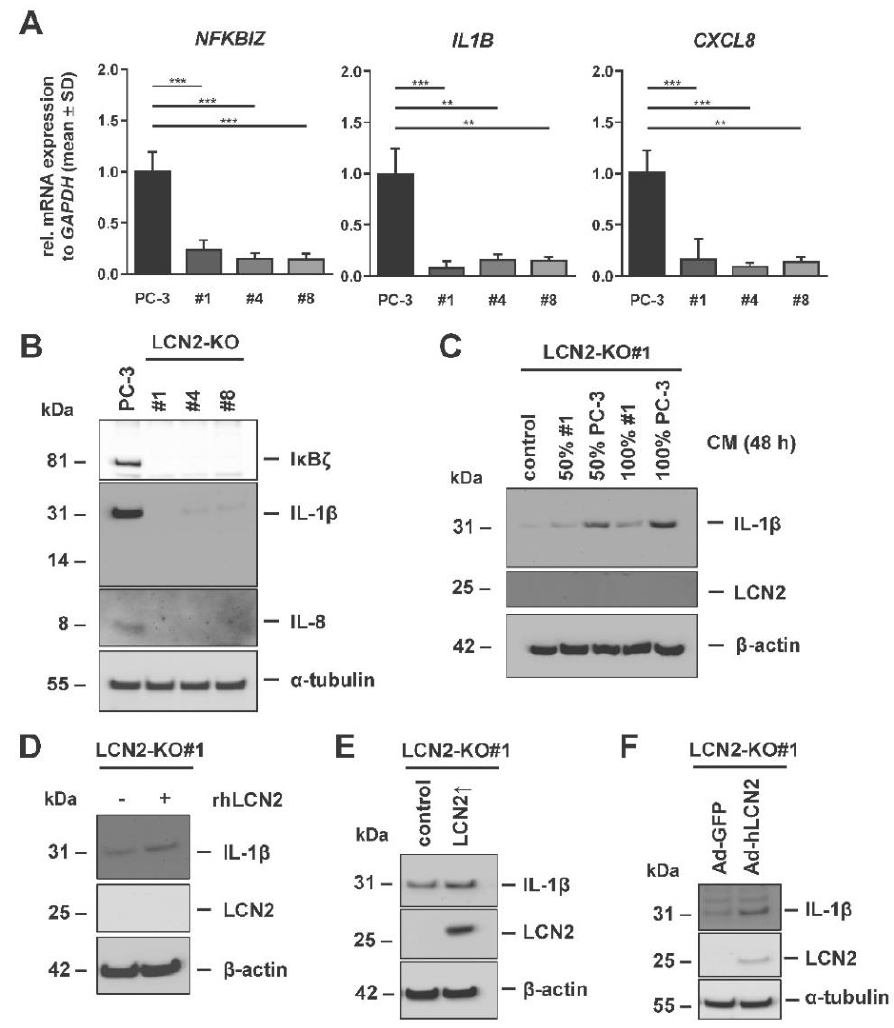
Figure 5. LCN2 depletion in PC-3 cells resulted in reduced expression of pro-inflammatory cytokines. ( A ) Quantitative mRNA expression analysis of NFKBIZ , IL1B and CXCL8 was performed in PC-3 and LCN2-KO (#1, #4, #8) cells grown in basal conditions (n = 3). The mRNA expression of these genes was significantly reduced in all analyzed LCN2-KO cells test. mRNA expression was normalized to GAPDH and are given in relation to parenteral PC-3 cells. Differences between the groups reaching significance are indicated as ** p < 0.01, *** p < 0.001. ( B ) Western Blot analysis confirmed reduction in I κ B ζ , IL-1 β and IL-8 protein expression in LCN2-KO cells compared to parental PC-3 cells (n = 3). ( C ) LCN2-KO#1 cells were stimulated for 48 h with indicated ratios of conditioned medium (CM) collected from PC-3 or LCN2-KO#1 cells. Western blot analysis revealed increased IL-1 β quantities in LCN2-KO#1 cells, treated with CM from PC-3 cells (n = 3). ( D ) LCN2-KO#1 cells were stimulated with recombinant human LCN2 (rhLCN2, 100 ng/mL) for 24 h. Western blot analysis showed enhanced IL-1 β expression in treated LCN2-KO#1 cells (n = 2). LCN2 was transiently